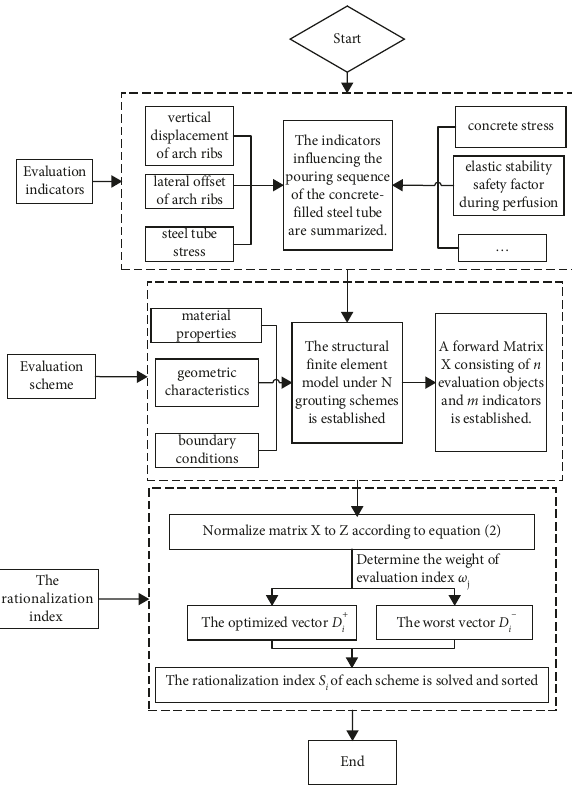
Figure 1: Flow chart of the optimized pouring scheme of the concrete-filled steel tube arch